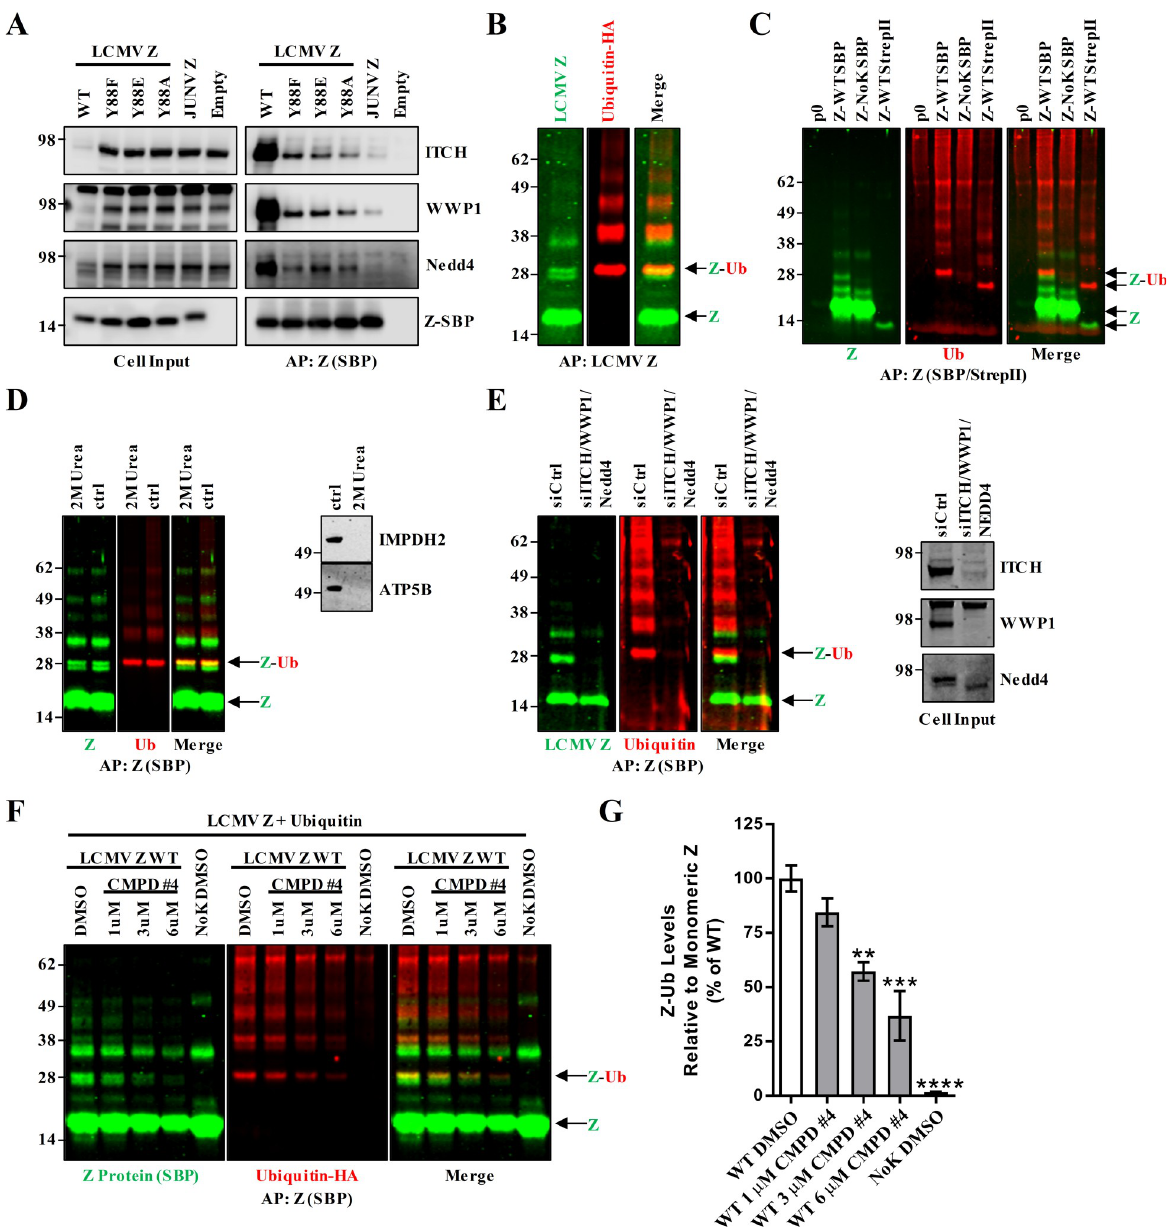
Fig 4. The LCMV Z protein is directly ubiquitinated on lysine residues by Nedd4 family ubiquitin ligases. (A) SBP-tagged LCMV Z (WT or Z with the tyrosine (88) in the PPXY late domain mutated), Junı´n virus (JUNV) Z, or an empty vector were expressed via plasmid in HEK293T cells. Z was affinity purified with streptavidin-coated magnetic beads and Z along with the Nedd4 family ubiquitin ligases ITCH, WWP1, and Nedd4 were detected via western blot. (B) SBP-tagged LCMV Z and hemagglutinin (HA)-tagged ubiquitin were expressed via plasmid in HEK293T cells and two days later Z was affinity purified (AP) with streptavidin beads and both Z and ubiquitin (Ub) were detected via two color fluorescent western blotting using anti-SBP and anti-HA antibodies. The Z monomeric band is indicated as well as overlapping bands at ~32kDa which may represent an ubiquitinated Z species (Z-Ub). (C) To distinguish between ubiquitinated host proteins and ubiquitinated Z, plasmids expressing either WT or lysine-free (NoK) LCMV Z with affinity tags of different molecular weights (SBP or Strep tag II) were co-transfected with HA-tagged ubiquitin in HEK293T cells and two days later Z was affinity purified with streptavidin beads and both Z and ubiquitin were detected via two color fluorescent western blotting using a combination of anti-SBP, anti-Strep tag II, and anti-HA antibodies. (D) In order to eliminate non-covalently interacting host proteins from co-purifying with LCMV Z, urea was added to the cell lysate to a concentration of 8M and incubated for 1 hour. The samples were then diluted with lysis buffer to reduce the urea concentration to 2 M and a streptavidin purification was performed. Western blotting was used to detect Z and ubiquitin as well as the known LCMV Z host partners IMPDH2 and ATP5B. (E) HEK293T cells were seeded then one day later small interfering (si)RNAs targeting ITCH, Nedd4, and WWP1 or a concentration of a non-targeting siRNA equal to the total of the three distinct siRNAs were transfected into the cells and two days later the cells were transfected with plasmids expressing SBP-tagged LCMV Z